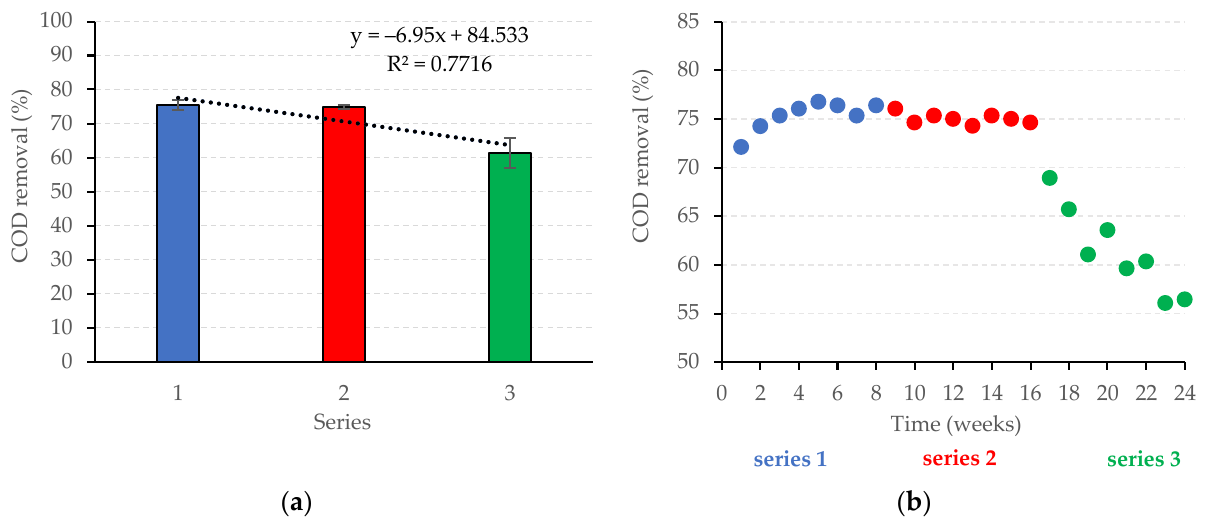
Figure 5. The efficiency of anaerobic confectionery wastewater treatment in stage 2: ( a ) average COD removal with the standard deviation; ( b ) COD removal during experimental time. Table 6. Removal of organic compounds such as COD, BOD 5 , TOC, and production of biogas and CH 4 in stage 2.